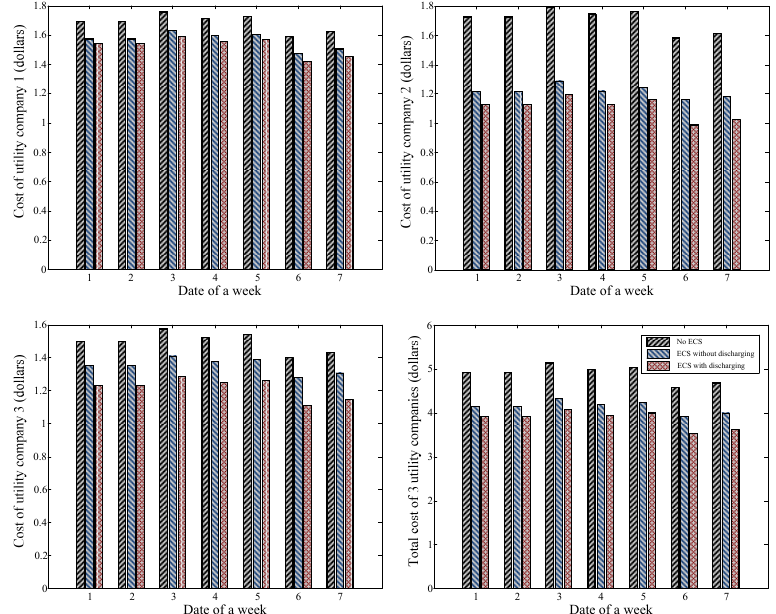
(cid:3) Figure 3. The cost of each utility company and the total of three utility companies with the